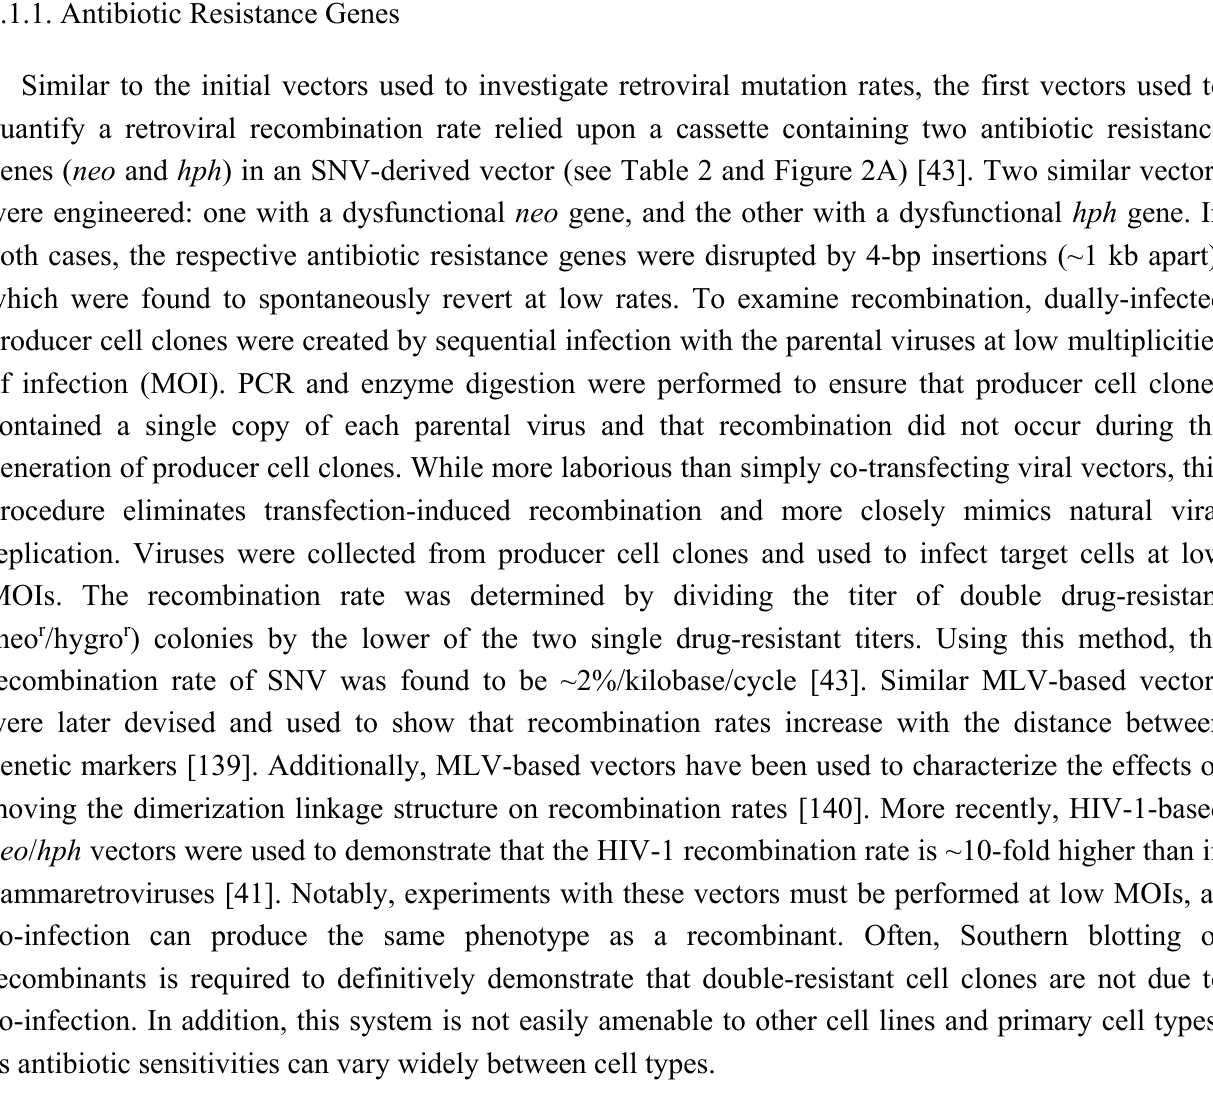
Table 2. Targets for analysis of retroviral